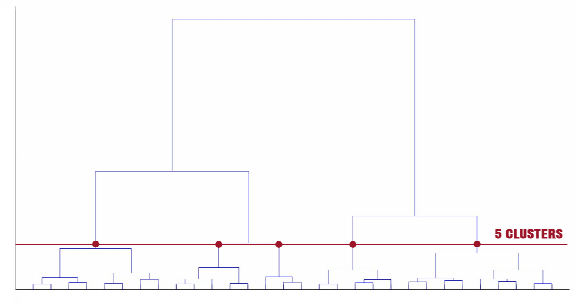
Figure 3 . Dendrogram of Case 1. Red line: pruning at 5 clusters; X-axis: clusters; Y-axis: Ward’s distance